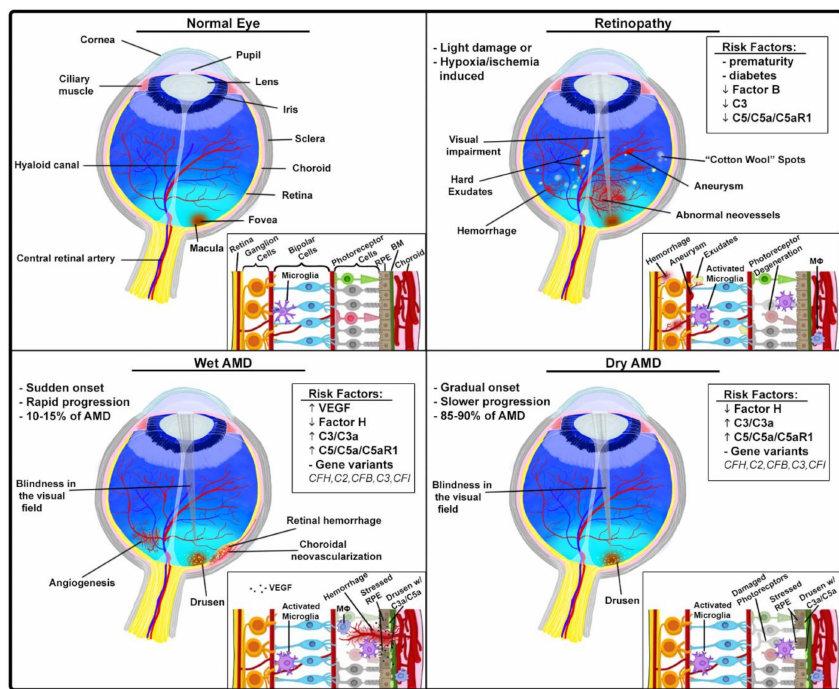
Figure 3. Ocular pathologies with complement involvement. Anatomy and histology of normal eye ( upper left ); proliferative retinopathies ( upper right ): the process of neovascularization leads to formation of blood vessels that are fragile and leaky, increased permeability or rupture of newly formed blood vessels and subsequent hemorrhage cause impairment or loss of vision, in mouse models of these retinopathies, complement seems to have a protective role; wet AMD ( lower left ) and dry AMD ( lower right ): in both forms, excessive complement activation and subsequent generation of complemente ff ectors(C3aandC5a)hasbeenimplicated; frequentlyAMDislinkedto FH polymorphism; in wet AMD, VEGF-driven neovascularization, possibly also regulated by complement, leads to severe impairment or loss of